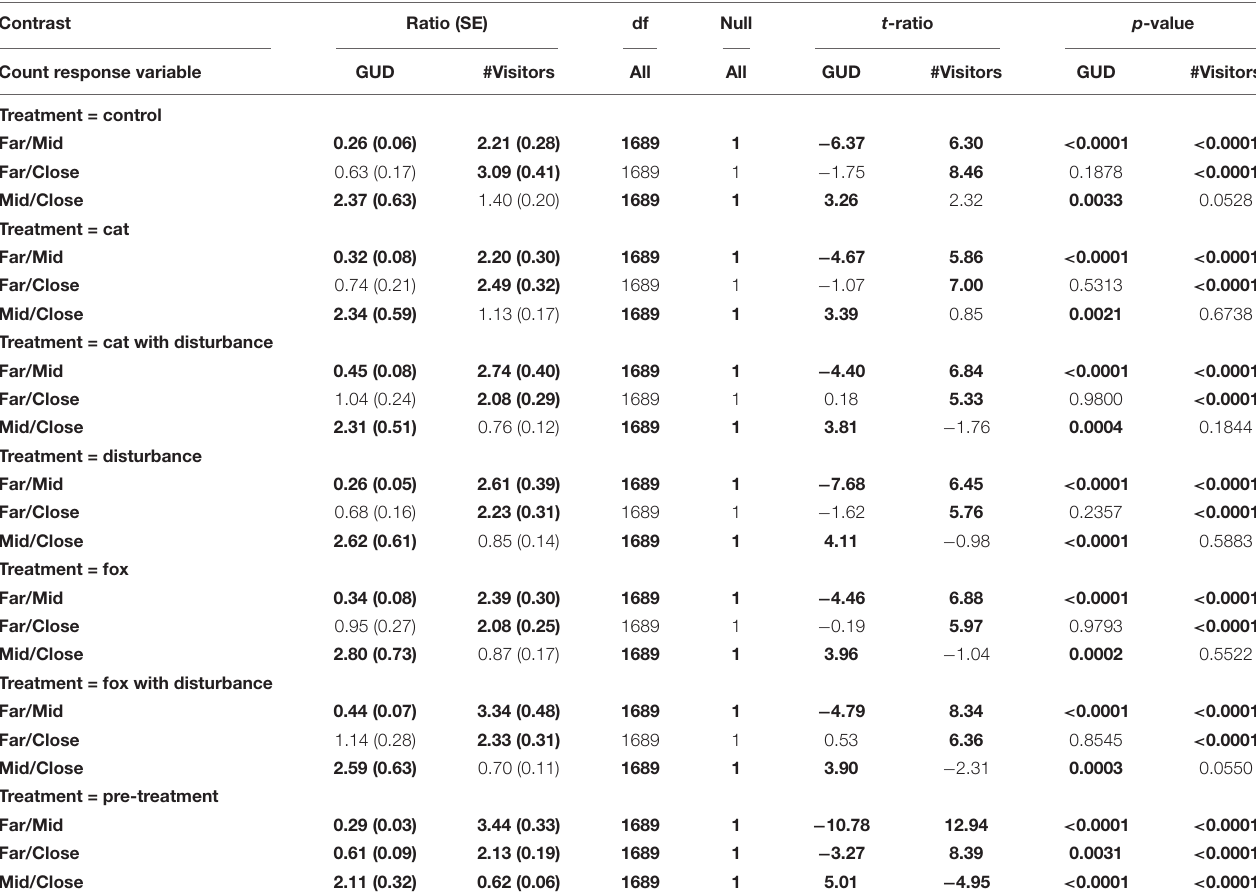
TABLE 6 | Pairwise contrast ratios for estimated marginal means comparing environments (close, mid, and far) along an urban disturbance gradient for giving-up density (GUD) responses and number of visitor responses, under the explanatory variables of treatment and environment. Contrast Ratio (SE) df